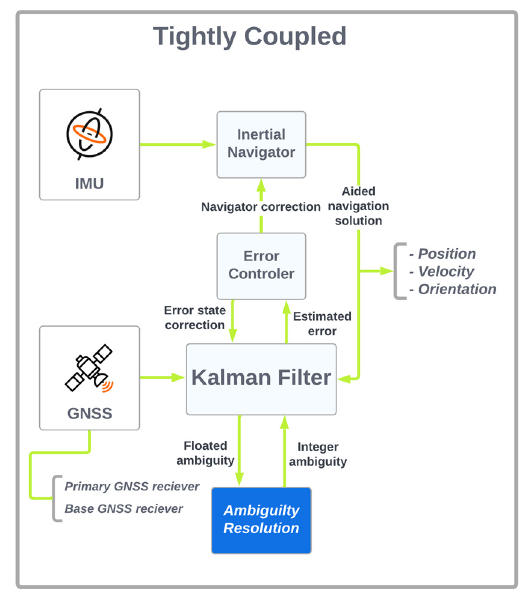
Figure 2. The tightly coupled scheme in GNSS/IMU integration